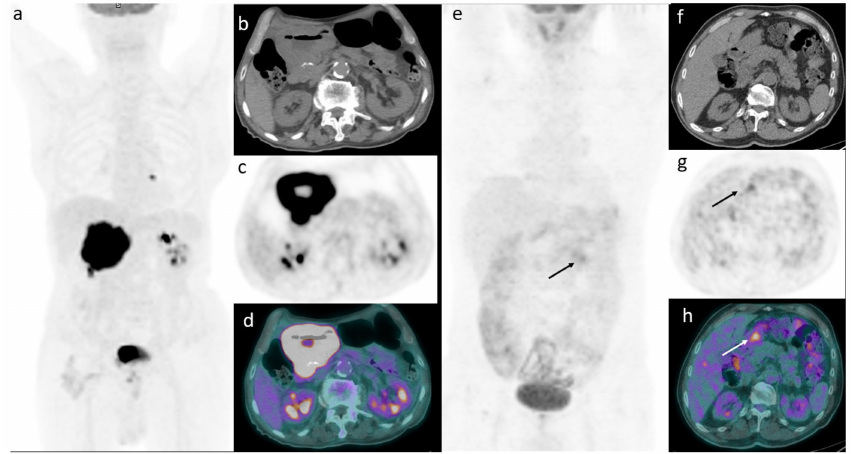
Figure 1. An example of a 76-year-old man affected by primary gastric DLBCL and a mediastinal lymph node. Baseline maximum intensity projection (MIP, a ) revealing diffuse hypermetabolic stomach uptake involving whole gastric wall with a SUVbw of 30, SUVlbm 24.5, SUVbsa 8.1, L-L SUV R 9.5, L-BP SUV R 13.4, gMTV 196, and gTLG 4317. Transaxial CT ( b ), transaxial PET ( c ) and transaxial PET/CT ( d ) showing the increased diffuse gastric uptake. Another example in a 46-year- old male with a diagnosis of primary gastric DLBCL and no other localizations of disease. MIP ( e ) showing faint-moderate uptake in the abdomen corresponding to a focal increased uptake in the antrum with a SUVbw of 5, SUVlbm 4.2, SUVbsa 1.4, L-L SUV R 2.4, L-BP SUV R 2.1, gMTV 19.9, and gTLG 165. Transaxial CT ( f ), transaxial PET ( g ), and transaxial PET/CT ( h ) displaying the increased FDG uptake.